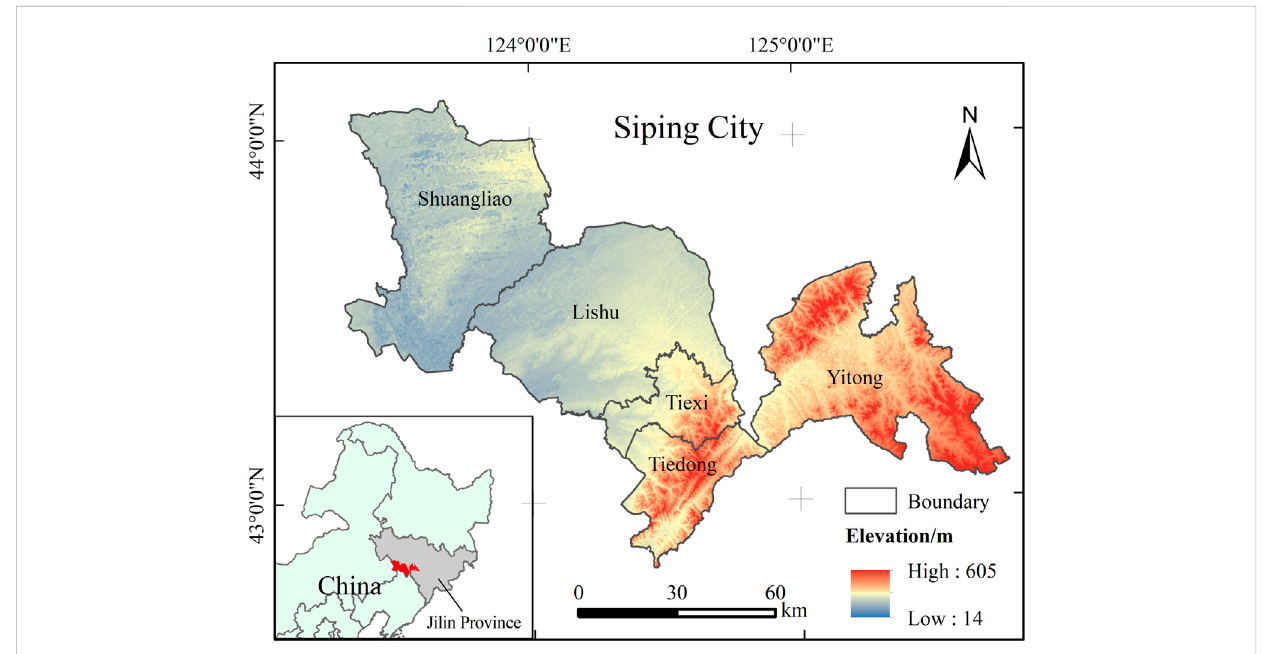
FIGURE 1 Geographical location and the digital elevation model of Siping